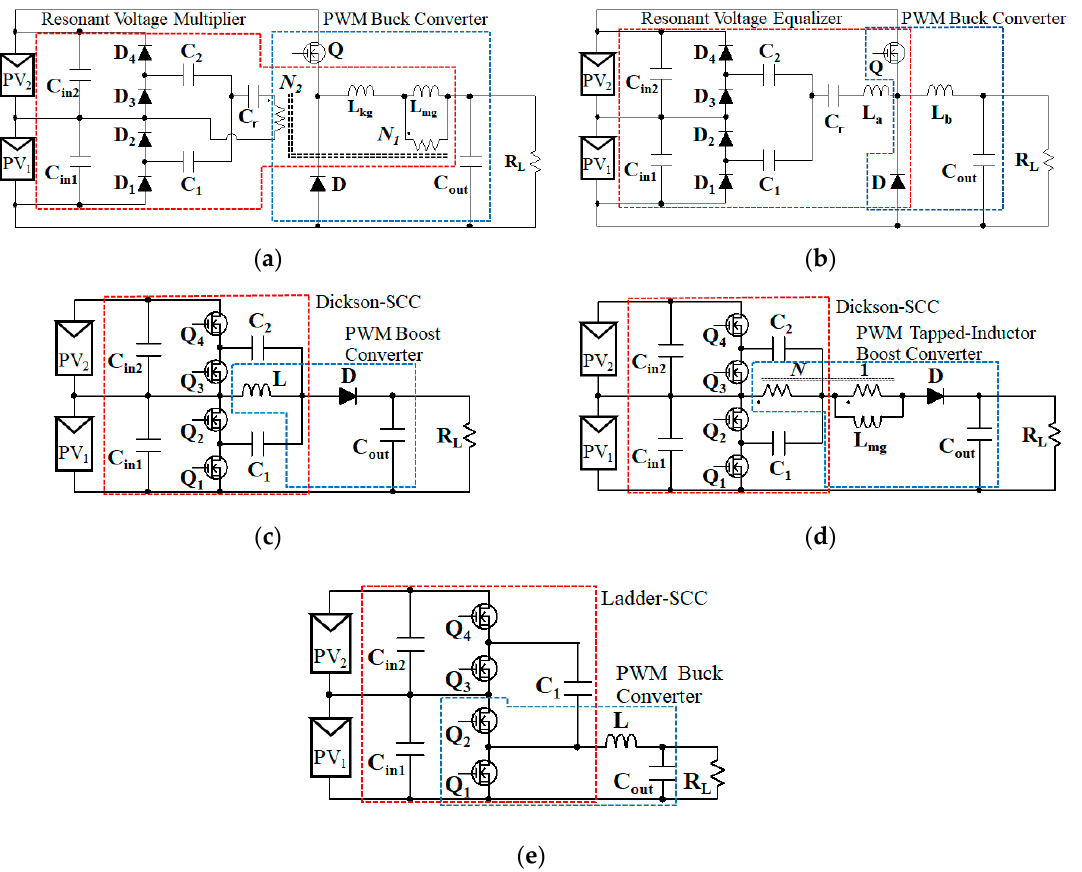
Figure 6. Integrated PWM converters: ( a ) Single-switch single-magnetic converter integrating resonant voltage multiplier (RVM), ( b ) Single-switch transformer-less converter, ( c ) Dickson-SCC converter, ( d ) Dickson-SCC tapped-inductor converter, ( e ) Ladder-SCC buck converter.